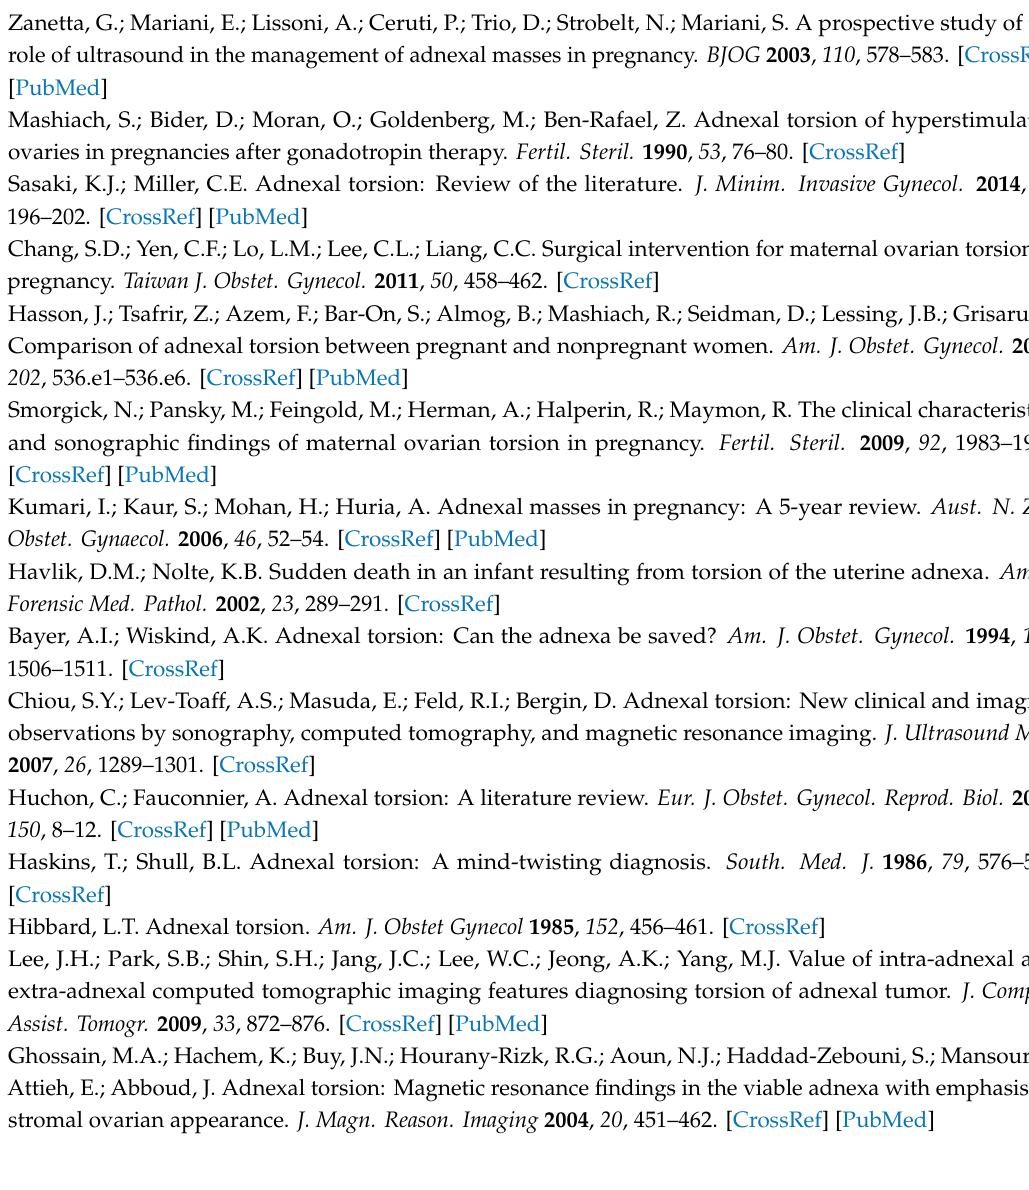
Table S1: MRI features of ovarian torsion, Table S2: Correlation between magnetic resonance image and surgical pathological diagnosis, Table S3: Rates of adnexal torsion diagnosed by MRI after ultrasound visualization of the ovary, Table S4: Inter-observer agreement for the di ff erent MR features by surgical